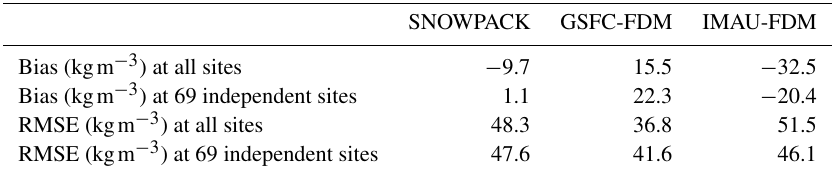
Figure 8. Density profile comparison. Mean observed (blue dashed), SNOWPACK-modeled (black dashed), GSFC-FDM-modeled (red dashed), and IMAU-FDM-modeled (yellow dashed) near-surface (0–10m) density profiles at 122 locations across the AIS (a) . Shading represents plus and minus 1 standard deviation across observed and modeled density profiles. Mean SNOWPACK minus observed (black dashed), GSFC-FDM minus observed (red dashed), and IMAU-FDM minus observed (yellow dashed) density profiles at 122 locations across the AIS (b) . Error bars represent 95% confidence intervals on bias means. Table 2. SNOWPACK-, GSFC-FDM-, and IMAU-FDM-simulated mean near-surface density bias and RMSE at all 122 sites and the 69 independent